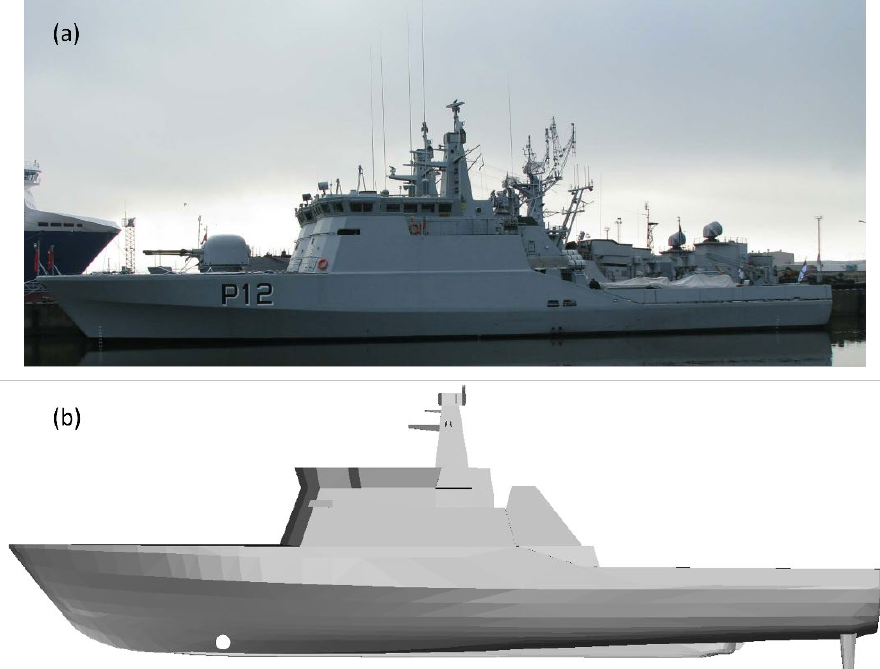
Figure 1. The original ( a ) and simplified model ( b ) of the Tejo class vessel.